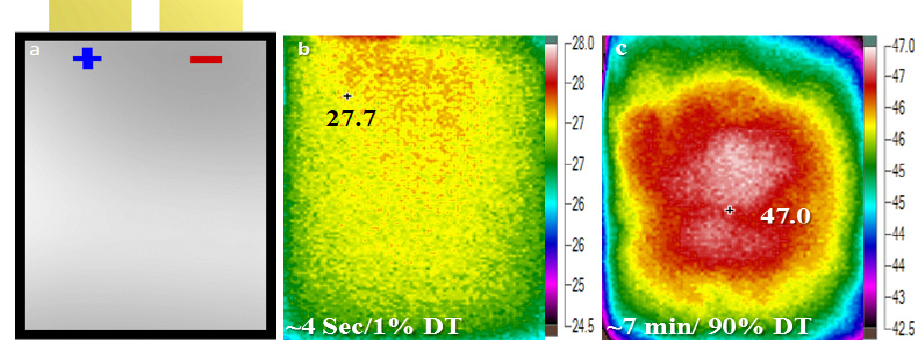
Figure 6. ( a ) Schematic of the LFP 14 Ah cell. IR images during discharge at 100 A along with the location of respective maximum temperature; ( b ) after ~4 s of discharge or ~1% of discharge time (DT); ( c ) after 7 min or ~90%